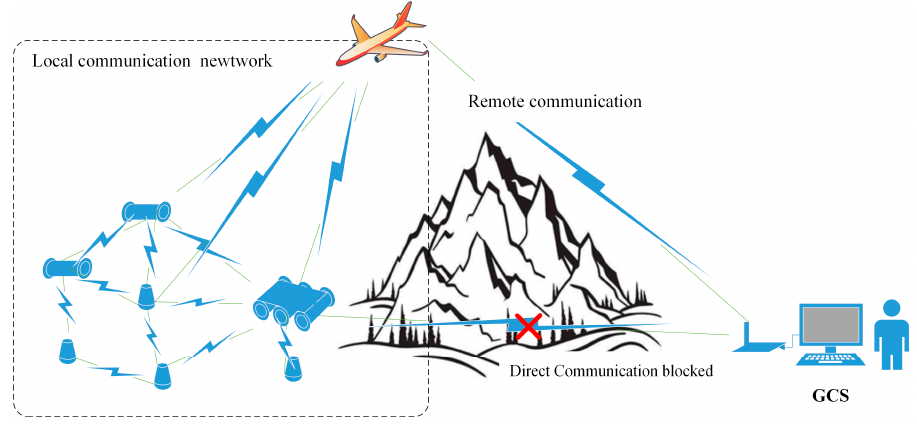
Figure 5. Communication link of the MSADM.